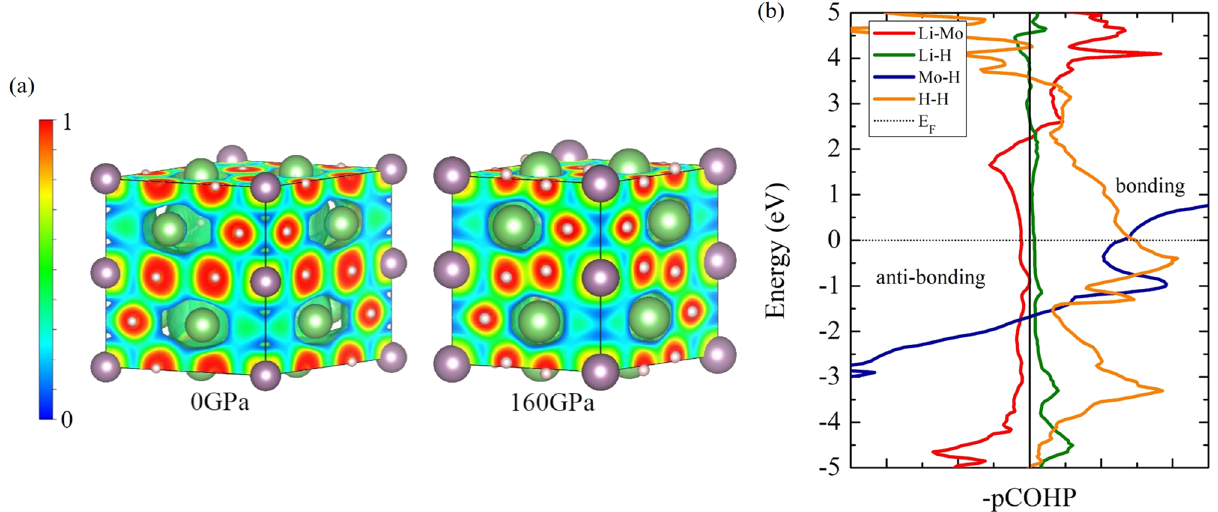
Figure 7. (a) The 3D-electron localization function (ELF) in Li 5 MoH 11 structure at 0 and 160 GPa, respectively. (drawn by VESTA (ver. 3.4.7) 65 (URL https ://jp-miner als.org/vesta /en/downl oad.html)) (b) Projected crystal orbital Hamilton populations (pCOHPs) in Li 5 MoH 11 structure at 160